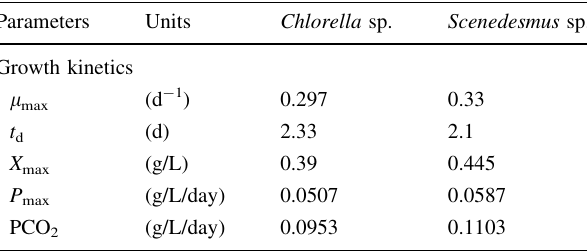
Table 2 Growth kinetic study of both strains in wastewater sample Parameters Units Chlorella sp. Scenedesmus sp.